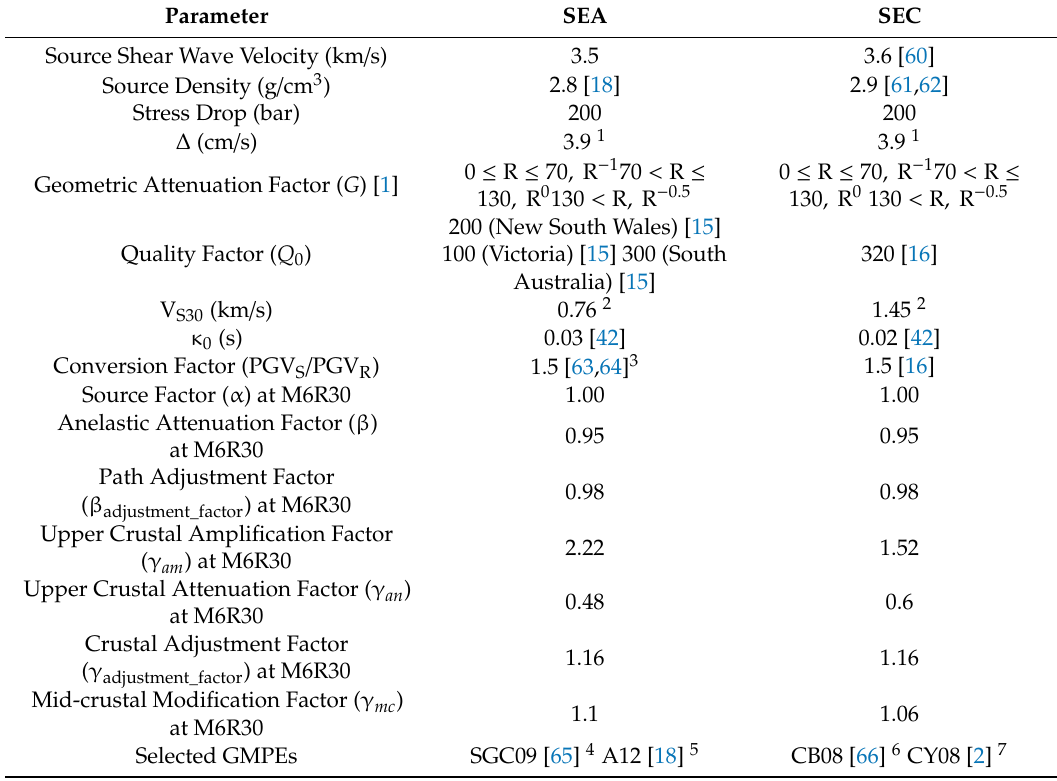
Table 4. Parameter values used in CAM for SEA and SEC alongside the selected